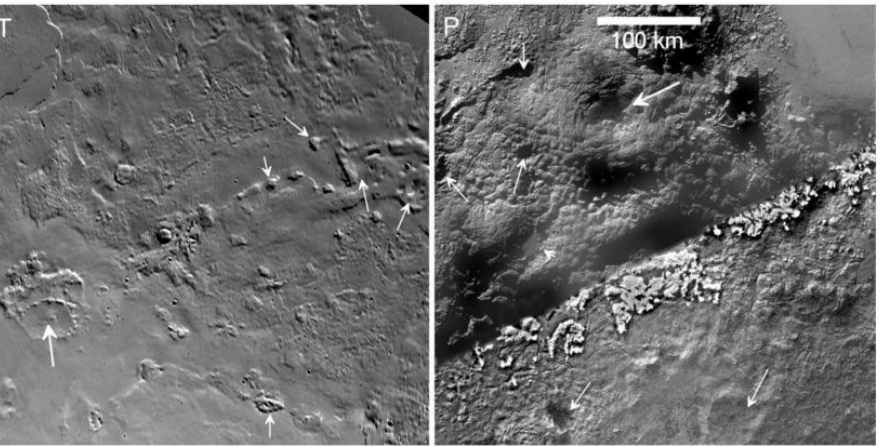
Figure 27. Volcanic terrains on (T) Triton and (P) Pluto. Images shown to same scale (0.350 km/pixel); scene width ~400 km. Pluto view shows Wright Mons and resurfaced plains of Hyecho Planitia. No directly analogous structures to Leviathan Patera are observed on other icy